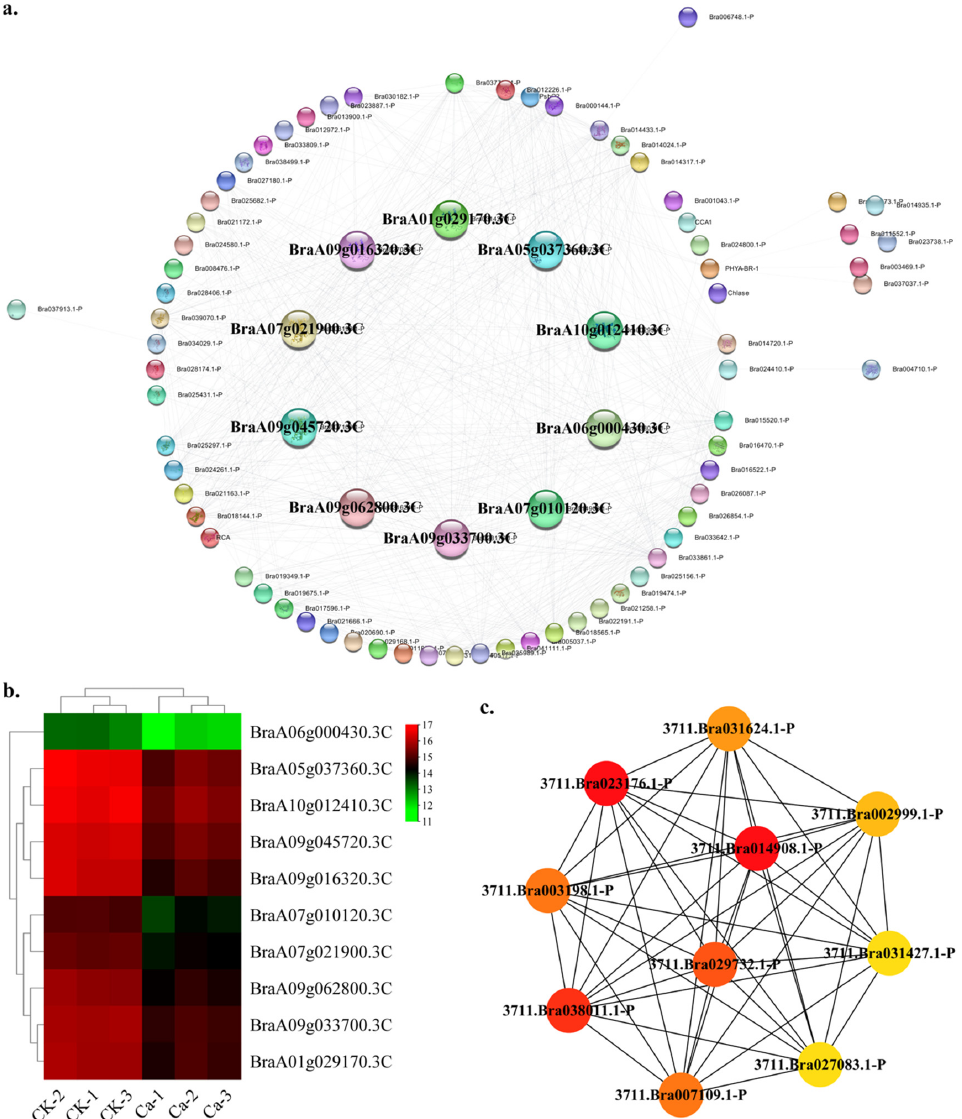
Figure 12. Protein–protein interaction (PPI) analysis in light-related DEGs category. ( a ) PPI network in light category. ( b ) Heatmap of the hub gene expression pattern. ( c ) Hub genes’ interactive relationship of the gene regulatory network.